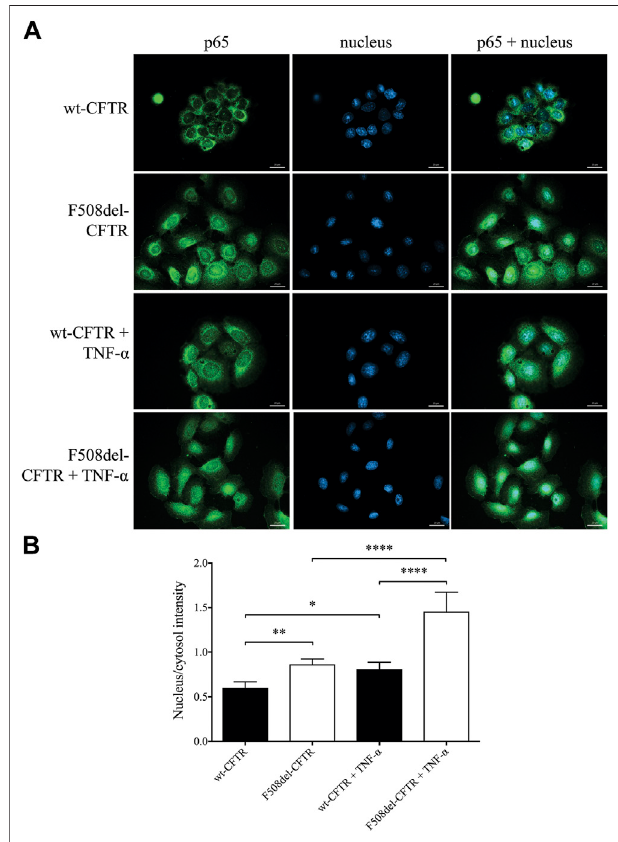
FIGURE 4 | Immuno fl uorescence staining with the quanti fi cation of nuclear/cytosol p65 positivity for detecting NF- κ B pathway activation in unstimulated and TNF- α treated CFBE 41o − cells expressing F508del-CFTR orwt-CFTR.Thebasallevelofp65nucleartranslocationwasanalyzed in respect to CFTR function when normal and F508del-CFTR CFBE 41o − cells were stimulated with 100 ng/ml TNF- α or PBS (baseline) for 4 h. Green: p65 staining; blue: cell nuclei. Scale bar: 20 μ m (A) Fluorescence intensity of the NF- κ B immunostaining was analyzed based on the ratio of the nucleus/ cytosolintensity (B) Mean ± SEM(n (cid:2) 6 – 7cells/condition).* p < 0.05, ** p < 0.01 and **** p < 0.0001 based on statistical